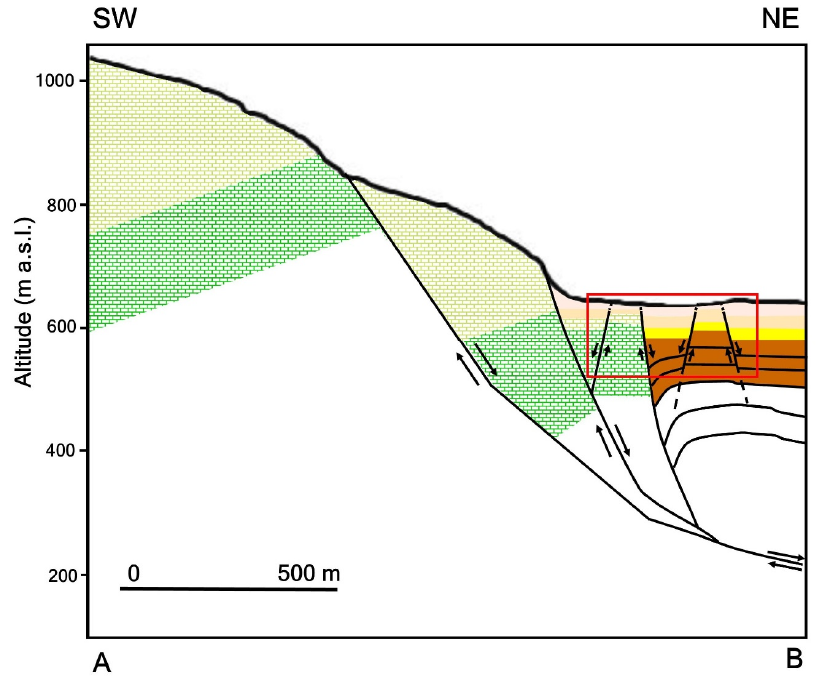
Figure 14. Geological cross section along AB (whose trace and geological units are shown in Figure 2); the red box is the interpreted profile of Figure 13. Based also on data from [16,49], we interpret the shallow horst and graben structure beneath the SW border of the Plain as due to the listric geometry of the Mt. Patalecchia fault system.